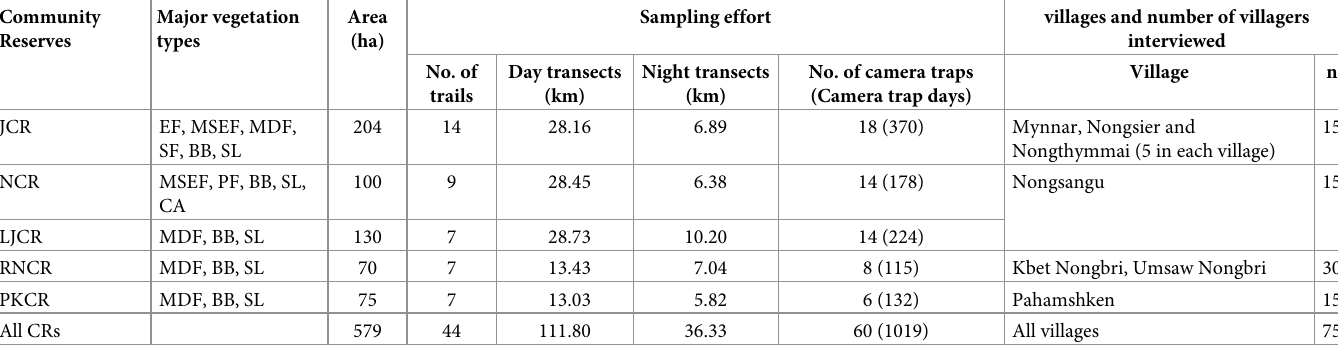
Table 1. Sampling effort for detecting mammals and people perception about mammals in each Community Reserve of Ri Bhoi district. Community Major vegetation Reserves